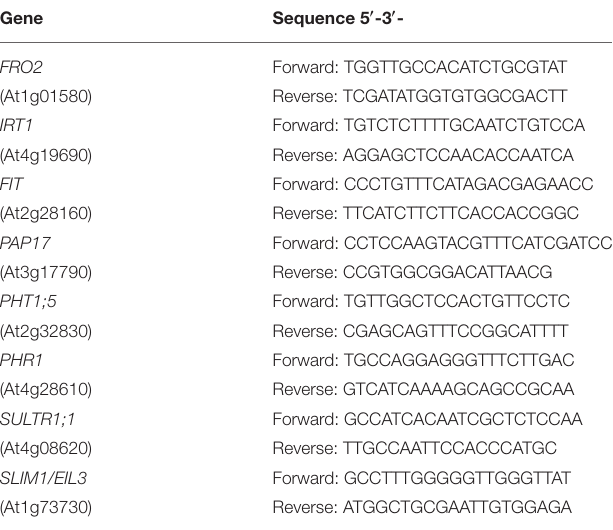
TABLE 1 | Primer pairs for Arabidopsis